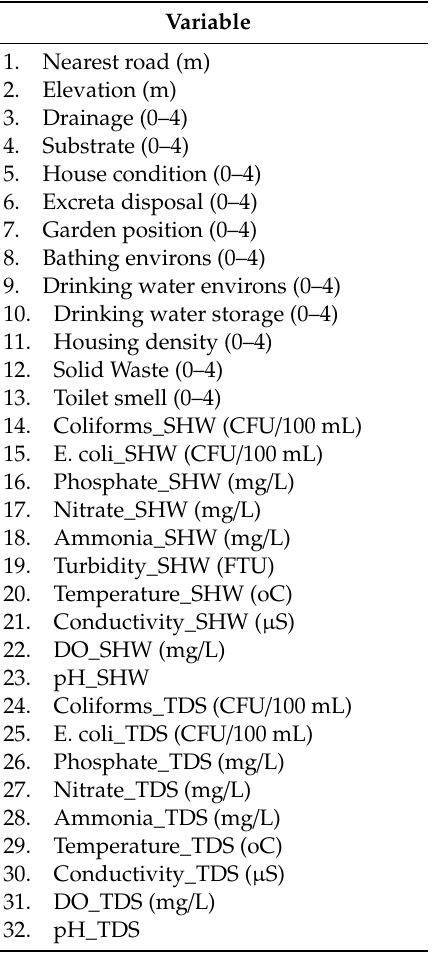
Table A4. Variables used in Exploratory Factor Analysis. SHW = source of drinking water; TDS = toilet drainage soil; DO = dissolved oxygen; CFU = colony forming